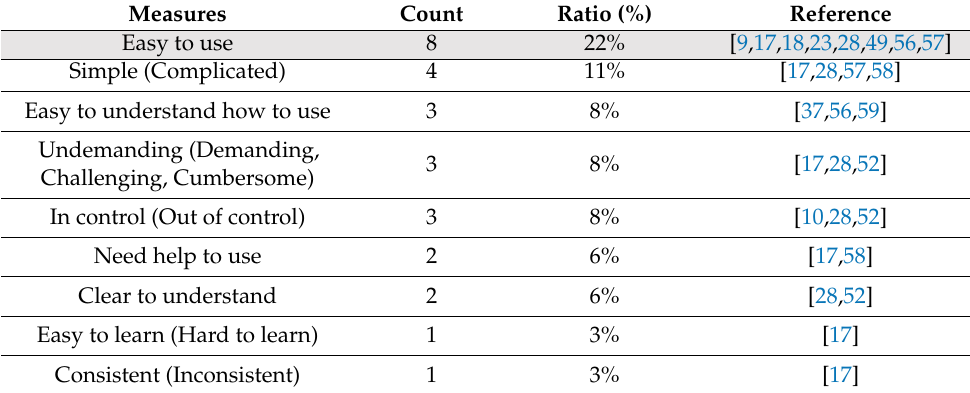
Table 4. Measures of ease-of-use.